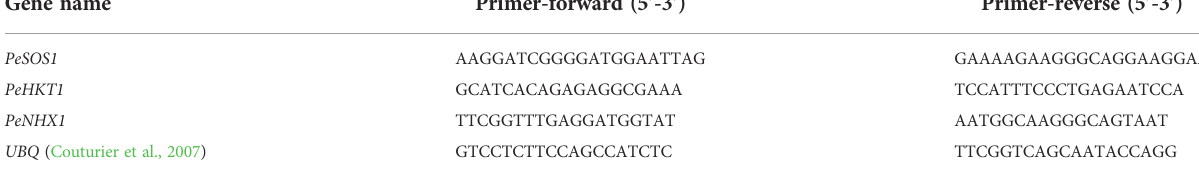
TABLE 1 Gene primers used for quantitative real-time PCR ampli fi